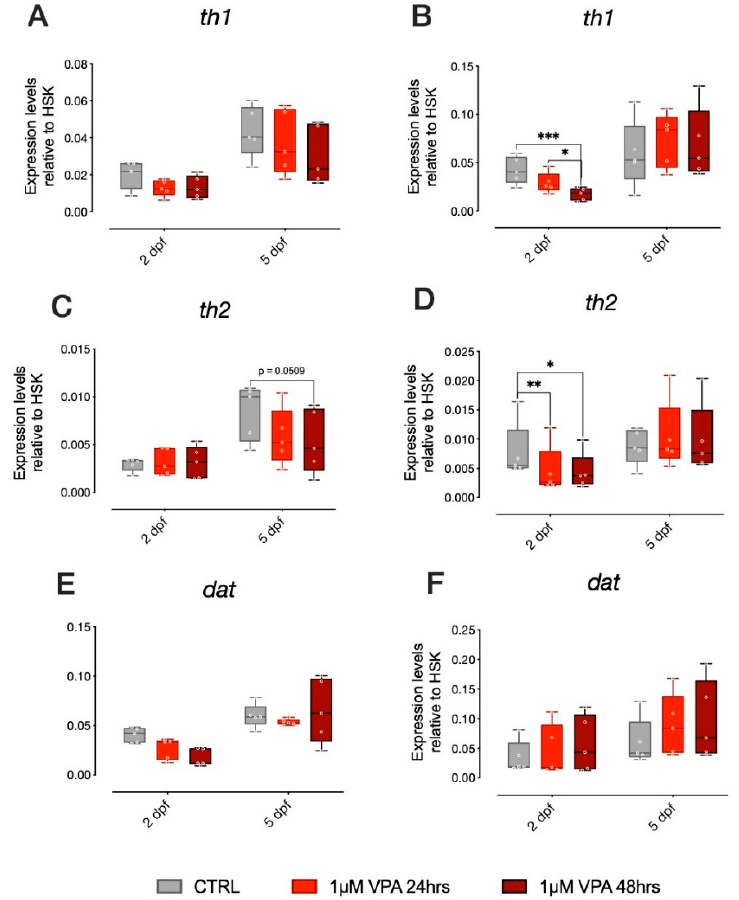
Figure 4. mRNA expression of key genes of dopaminergic system in 2 dpf and 5 dpf AB and TU zebrafish after 24 or 48 h of 1 µ M VPA. Changes in the expression of th1 ( A , B ), th2 ( C , D ) and dat ( E , F ) in AB ( A , C , E ) and TU ( B , D , F ) zebrafish embryos. Box plot (median, min to max) of mean dCt values for each group. **** p < 0.0001, *** p < 0.001, ** p < 0.01, * p <